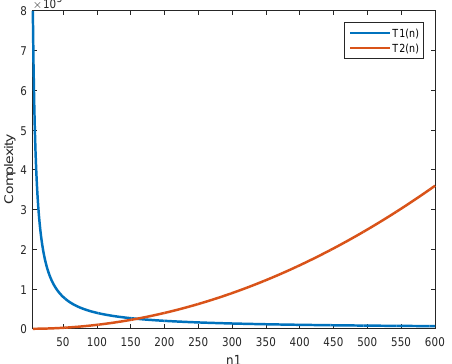
Fig. 2: Illustrating for the Automatic clustering output